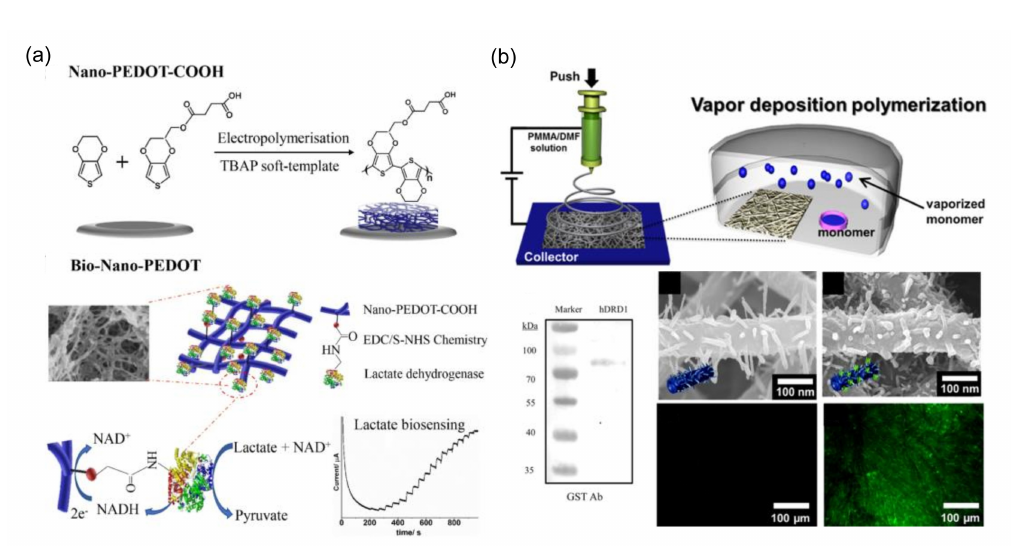
Figure 10. ( a ) The 3D PEDOT nanofiber network from the tetrabutylammonium perchlorate (TBAP) soft template for lactate detection [132]. Copyright 2020, Elsevier. ( b ) Multidimensional PEDOT nanofiber membranes via a modified vapor deposition polymerization method for dopamine detection [133]. Copyright 2016, American Chemical